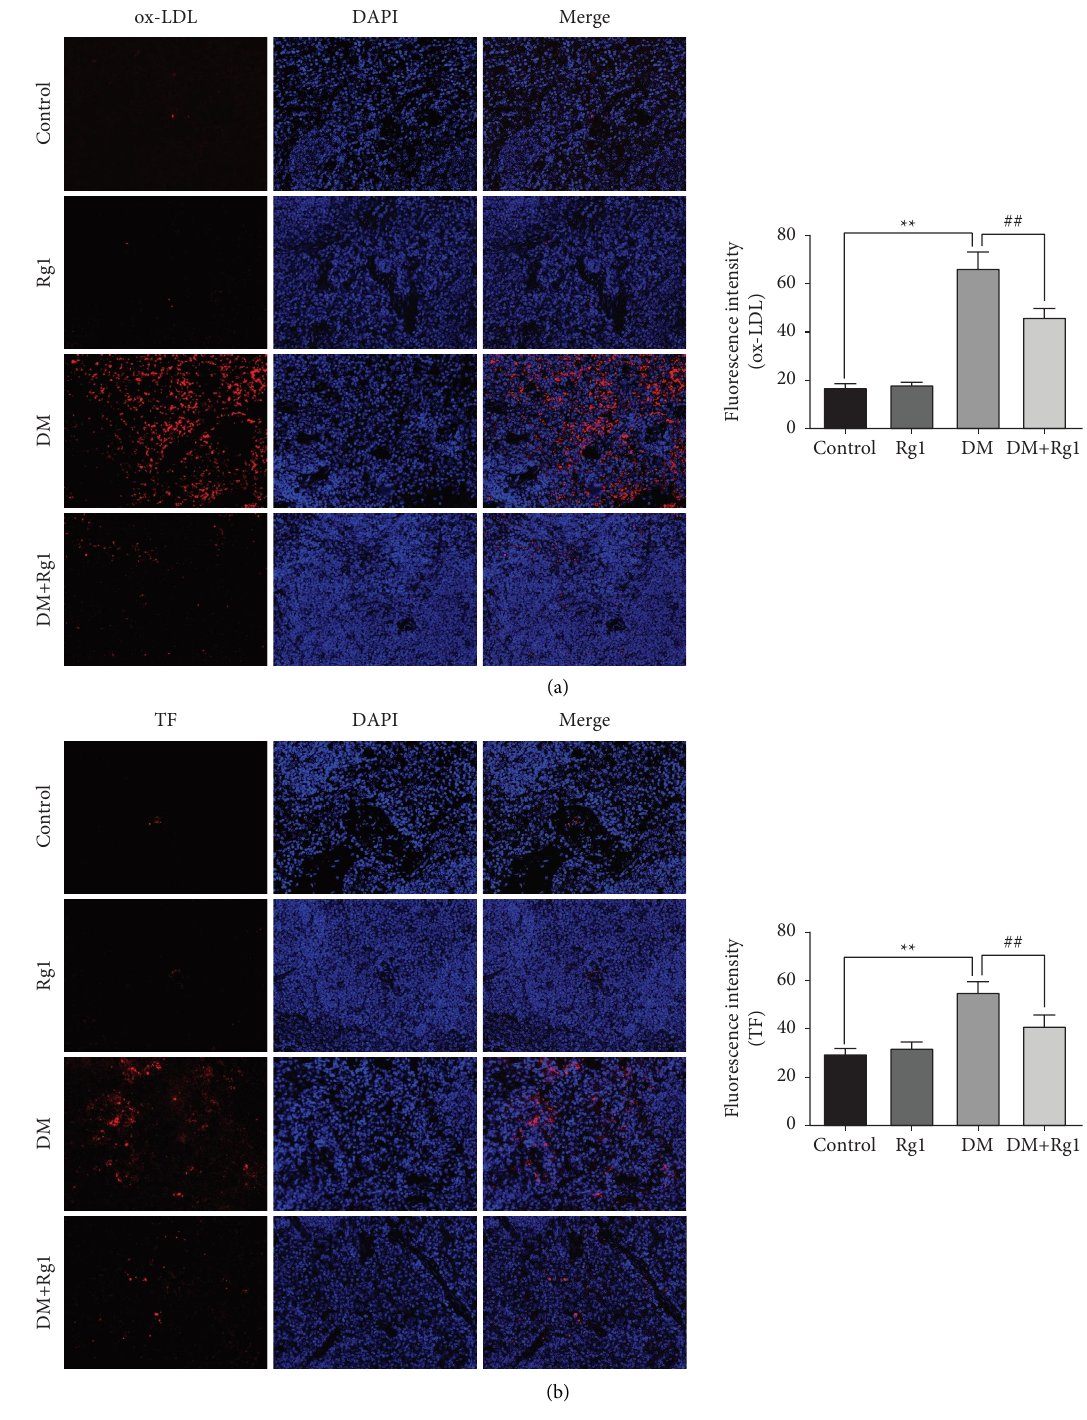
Figure 6: Te ox-LDL and TF proteins are expressed in the spleen through immunofuorescence. ( × 400, Scale: 50 μ m; mean ± SD; n � 6) (a) the expression of ox-LDL protein in the spleen. (b) Te expression of TF protein in the pancreas. Te fuorescence intensity was detected to observe the protein expression. Tese results suggest the improvement of Rg1 on the spleen of type 1 diabetes mice may be caused by inhibiting the ox-LDL and TF levels. ∗∗ p < 0 . 01, vs. the control group; ## p < 0 . 01 vs. the DM